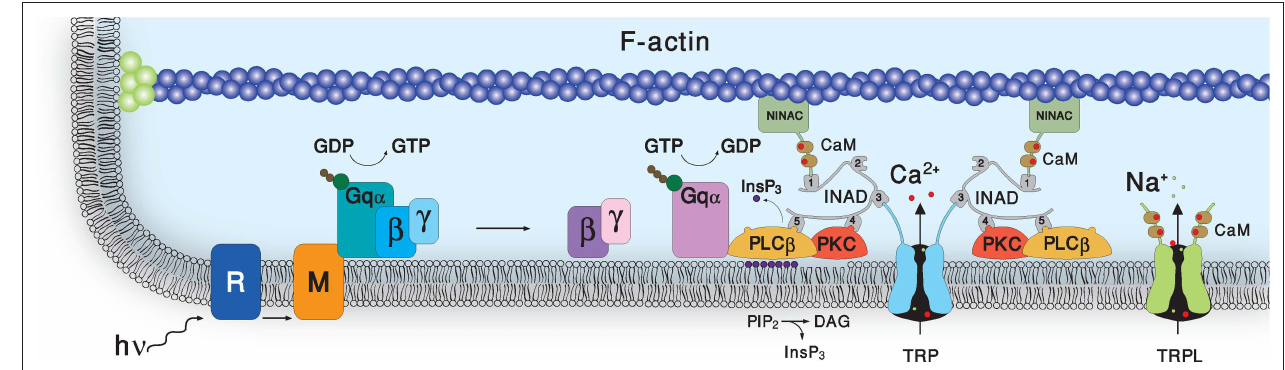
FIGURE 4 | Schematic representation of the molecular components of the signal transduction cascade of Drosophila . Upon absorption of a photon, rhodopsin (R) is converted into metarhodopsin (M). This photoconversion leads to the activation of heterotrimeric G-protein (G promoting the GDP to GTP exchange. In turn, this leads to activation of phospholipase C β (PLC β ), which hydrolyzes PIP the membrane-bound DAG. Subsequently, two classes of light-sensitive